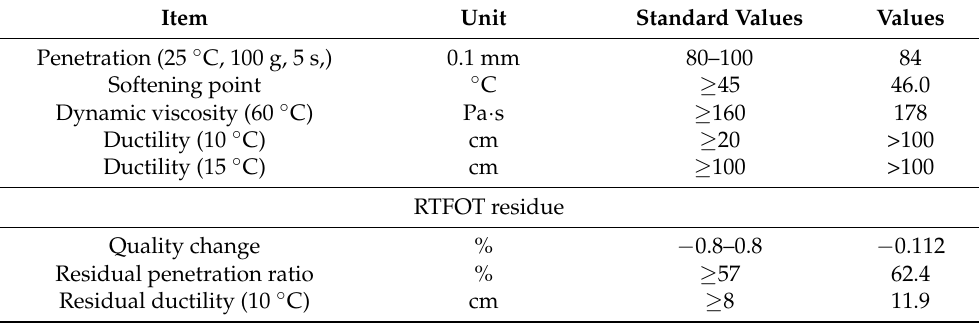
Table 1. Basic performances of neat asphalt.